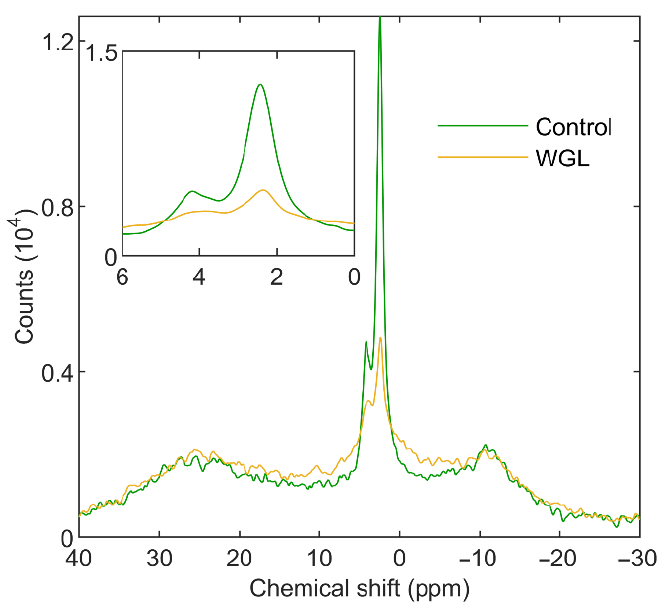
Figure 6. 31 P-NMR spectra of spinach thylakoid membranes untreated (green) and treated with 5, 20, and 100 U mL − 1 WGL (yellow, brown, and black, respectively). Average of three spectra from independent experiments; each spectrum was recorded within the first hour of treatment; temperature, 5 ◦ C. Inset shows the isotropic region. The spectra were normalized to total Chl contents of 10 mg mL − 1 and 105 min acquisition times.